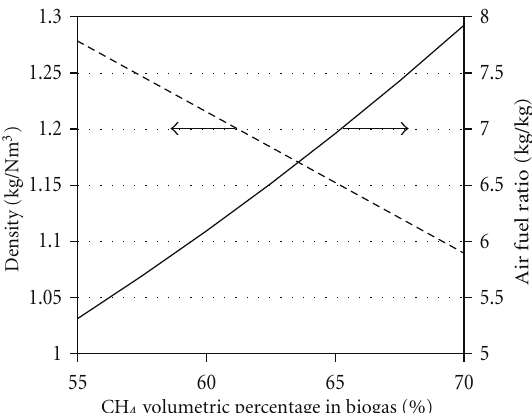
Figure 1: Biogas density and stoichiometric air fuel ratio.